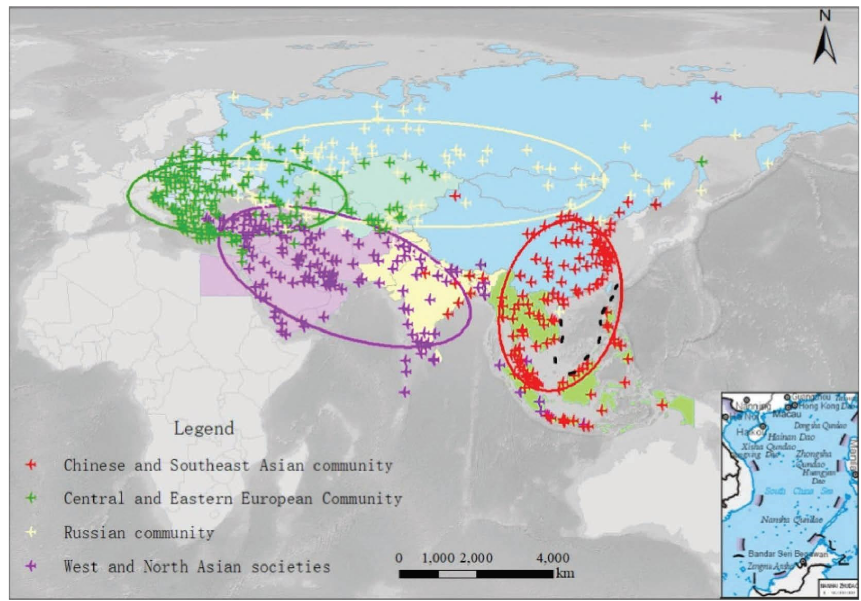
Figure 5: Geographical distribution of